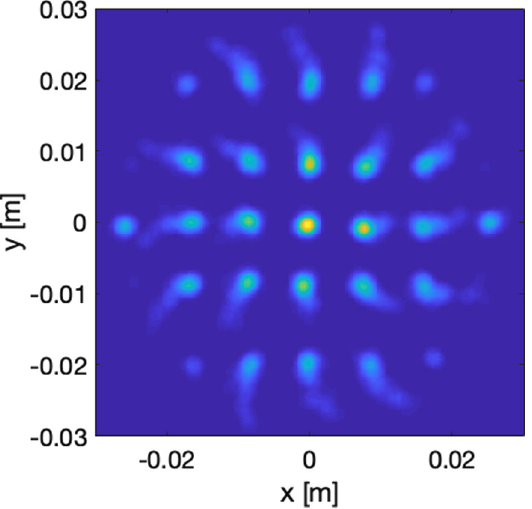
FIG. 6. Simulated viewer image of 5 superimposed vertical measurements, rotated to remove the average angular